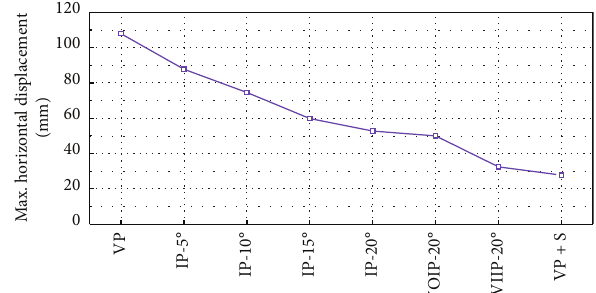
Figure 4: Maximum horizontal displacement of different retaining structures in profile M-1 calculated by FEM.